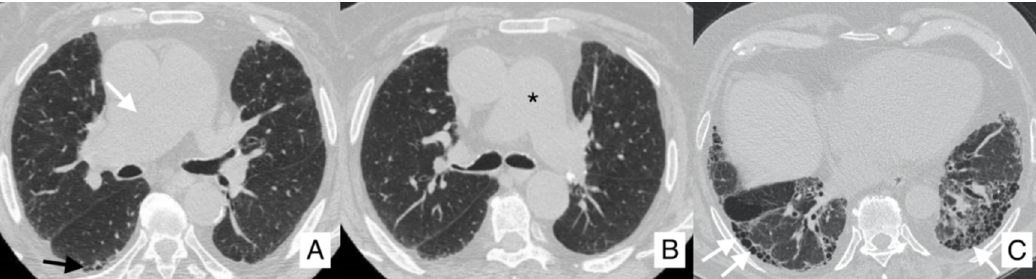
Figure 11. A 77-year-old patient with IPF and pulmonary hypertension (PH). ( A , B ) clearly demonstrate the enlargement of the right pulmonary artery (white arrow) and pulmonary trunk (black asterisk). Small cystic areas may be appreciated in the apical segment of the right lower lobe (black arrow). Reticulation bronchiectasis and honeycomb areas are well-depicted in ( C ) (white